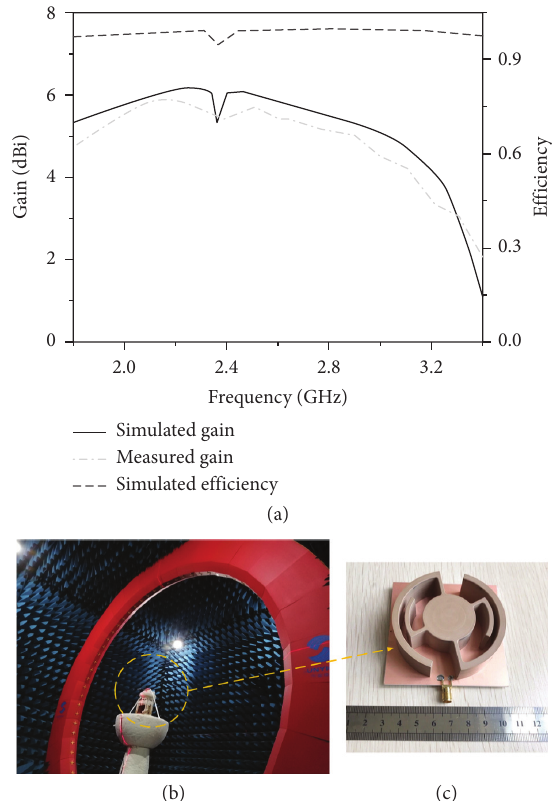
Figure 7: (a) Measured and simulated antenna gains, (b) simulated radiation efficiency, (c) and the photograph of the measurement environment as well as antenna